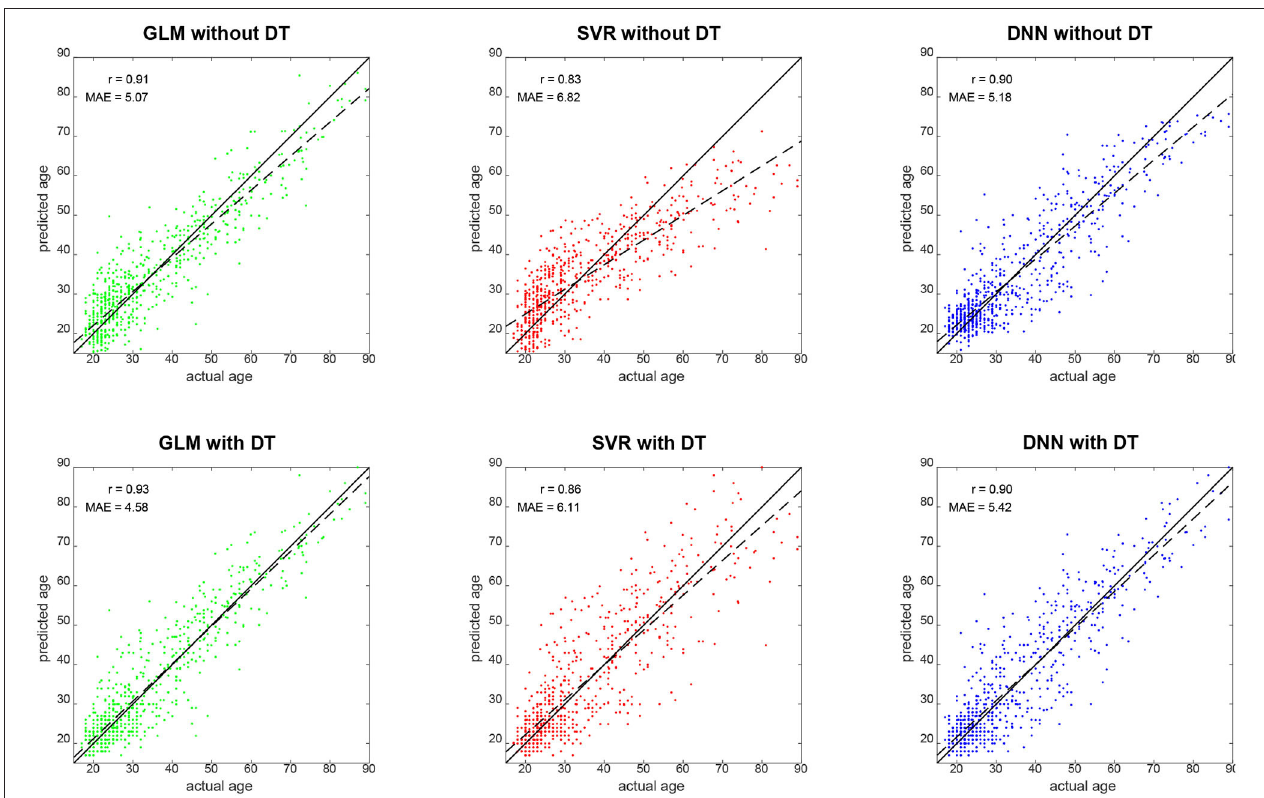
FIGURE 2 | Predicted vs. actual age for validation set subjects. Solid black lines denote the identity function and dashed black lines are regression lines. Also reported are correlation coefficients ( r ) and mean absolute errors (MAE) for each analysis (see Figure 3 ). GLM, multiple linear regression; SVR, support vector regression; DNN, deep neural network regression; DT, distributional